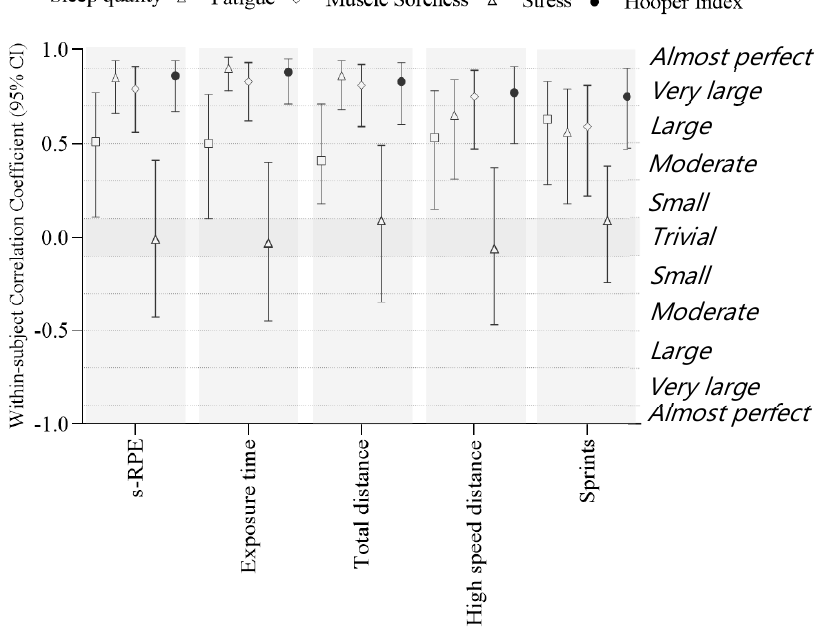
Figure 1. Within-subject correlation coefficients (95% confidence limits) between perceived well-being indices (i.e., sleep quality, fatigue, muscle soreness and stress; Hooper Index) and measures of workload (i.e., s-RPE, exposure time, total distance, high-speed distance, and number of sprints). Correlation coefficient is significant at p < 0.05. Abbreviations: s-RPE, session-rating of perceived exertion. The Hooper Index presented very large positive correlations with s-RPE ( r = 0.86 [0.67, 0.94]; p < 0.001), exposure time ( r = 0.88 [0.71, 0.95]; p < 0.001), total distance ( r = 0.83 [0.60, 0.93]; p < 0.001), high-speed distance ( r = 0.77 [0.50, 0.91]; p < 0.001), and number of sprints ( r = 0.75 [0.47, 0.90]; p < 0.001). Sleep quality presented large positive correlations with s-RPE ( r = 0.51 [0.11, 0.77]; p = 0.01), exposure time ( r = 0.50 [0.10, 0.76]; p = 0.01), high-speed distance ( r =